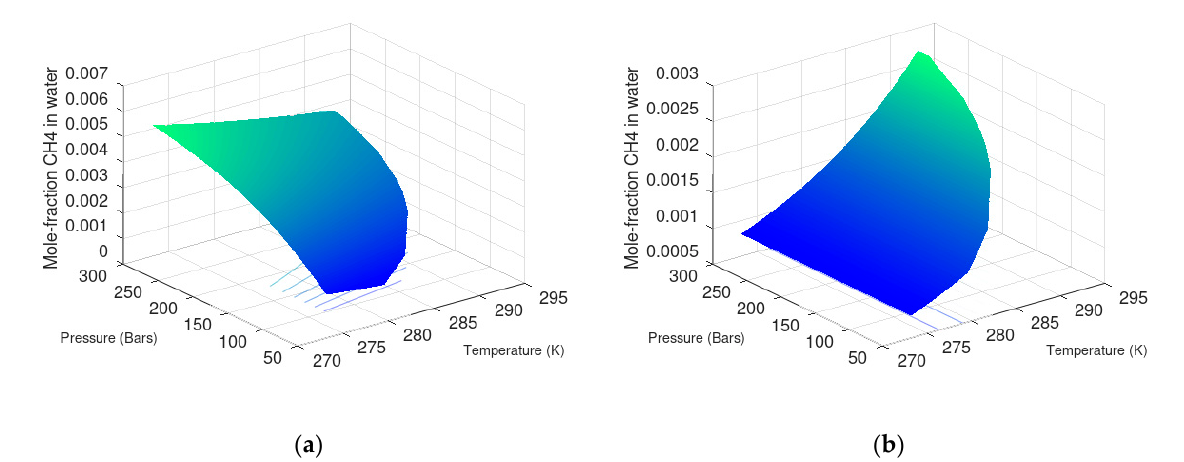
Figure 13. Pure water solubility for CO 2 and hydrate stability limits for CO 2 . ( a ) Solubility of CO 2 in water for the range of hydrate forming conditions. ( b ) Hydrate stability limit concentrations for CO 2 .